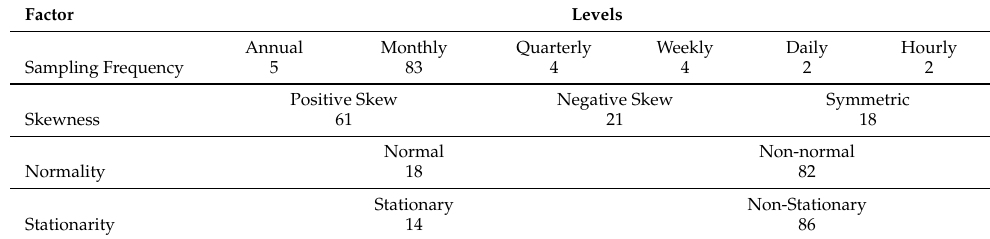
Table 1. Number of time series with each